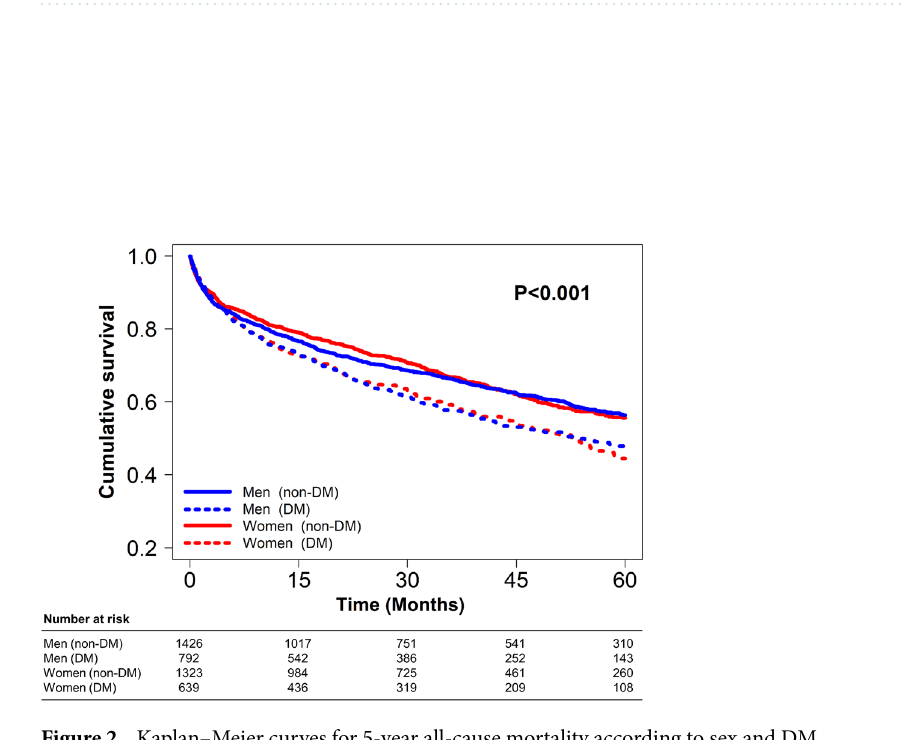
Figure 2. Kaplan–Meier curves for 5-year all-cause mortality according to sex and